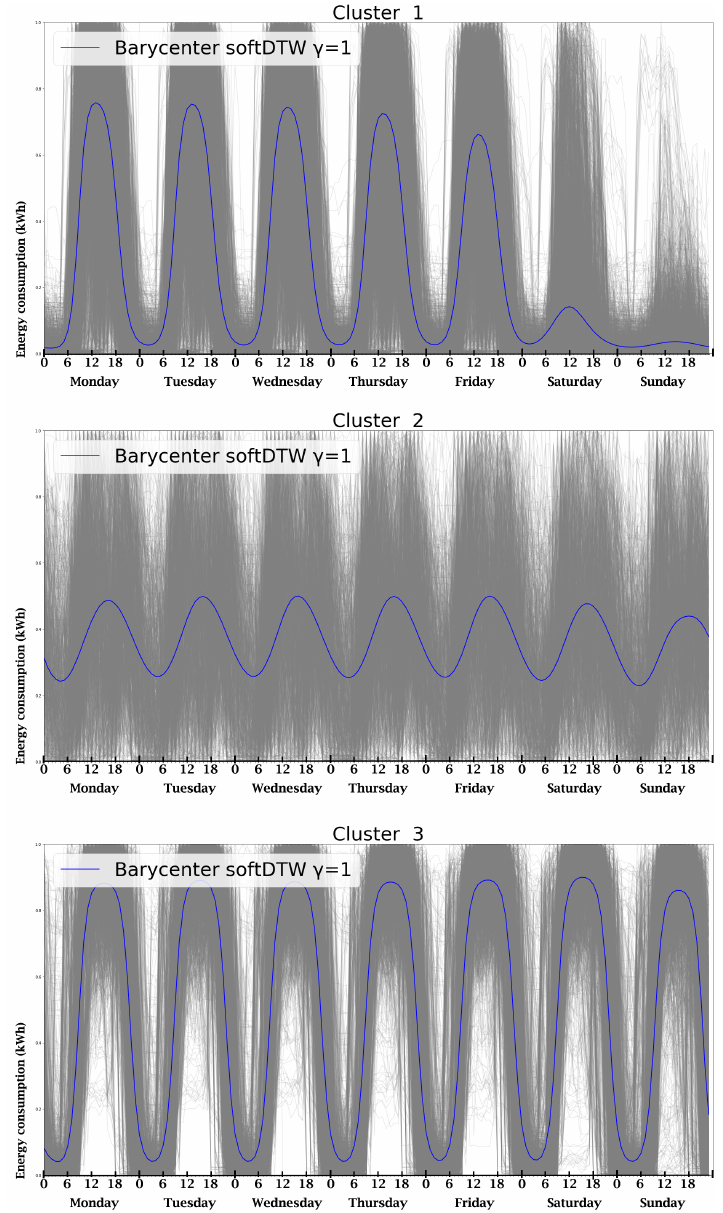
Figure 4. The figure shows the generated time series clusters, which model a typical week of consumption in each month for each SM. The time series for each SM are represented in grey, and blue represents the barycenter of each cluster obtained by soft-DTW with k = 3 and γ =